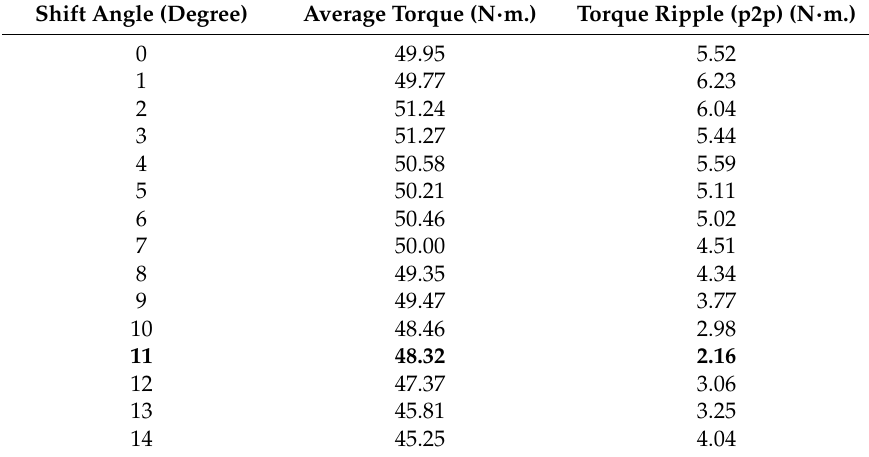
Table 3. The results of the 3D-FEA parametric analysis of the shifting